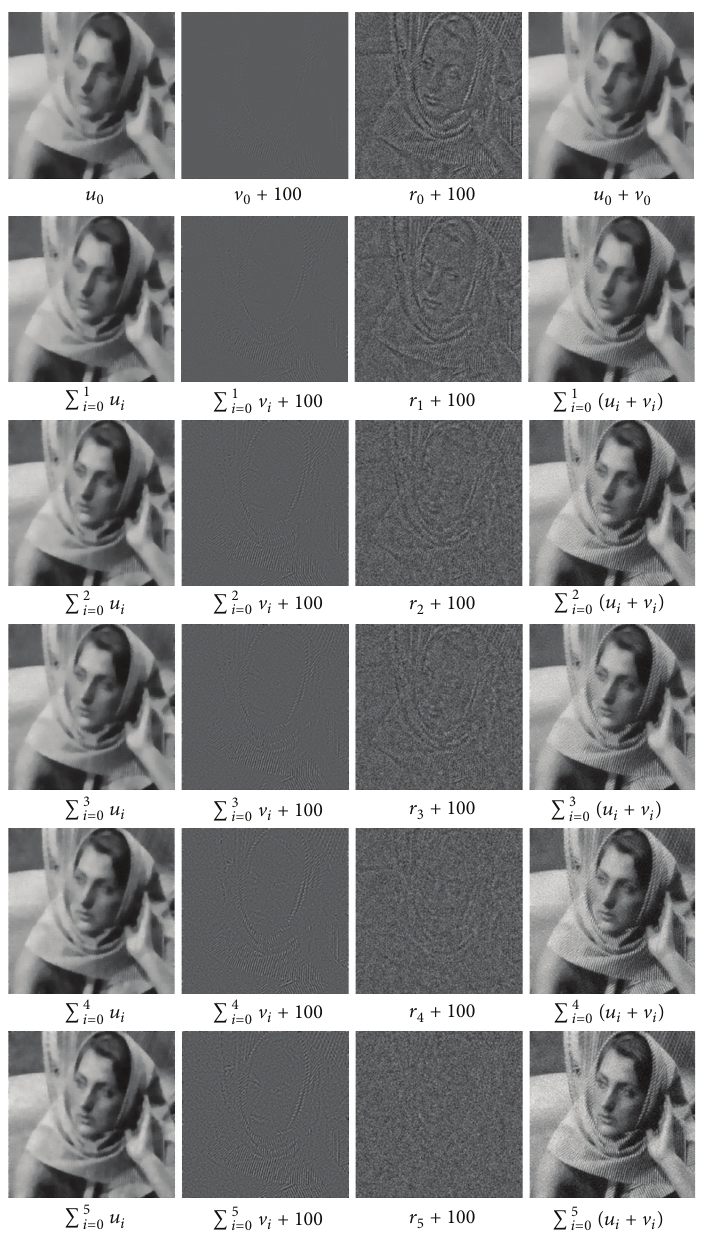
Figure 6: Multiscale image representation using hierarchical decomposition of a noisy Barbana for 6